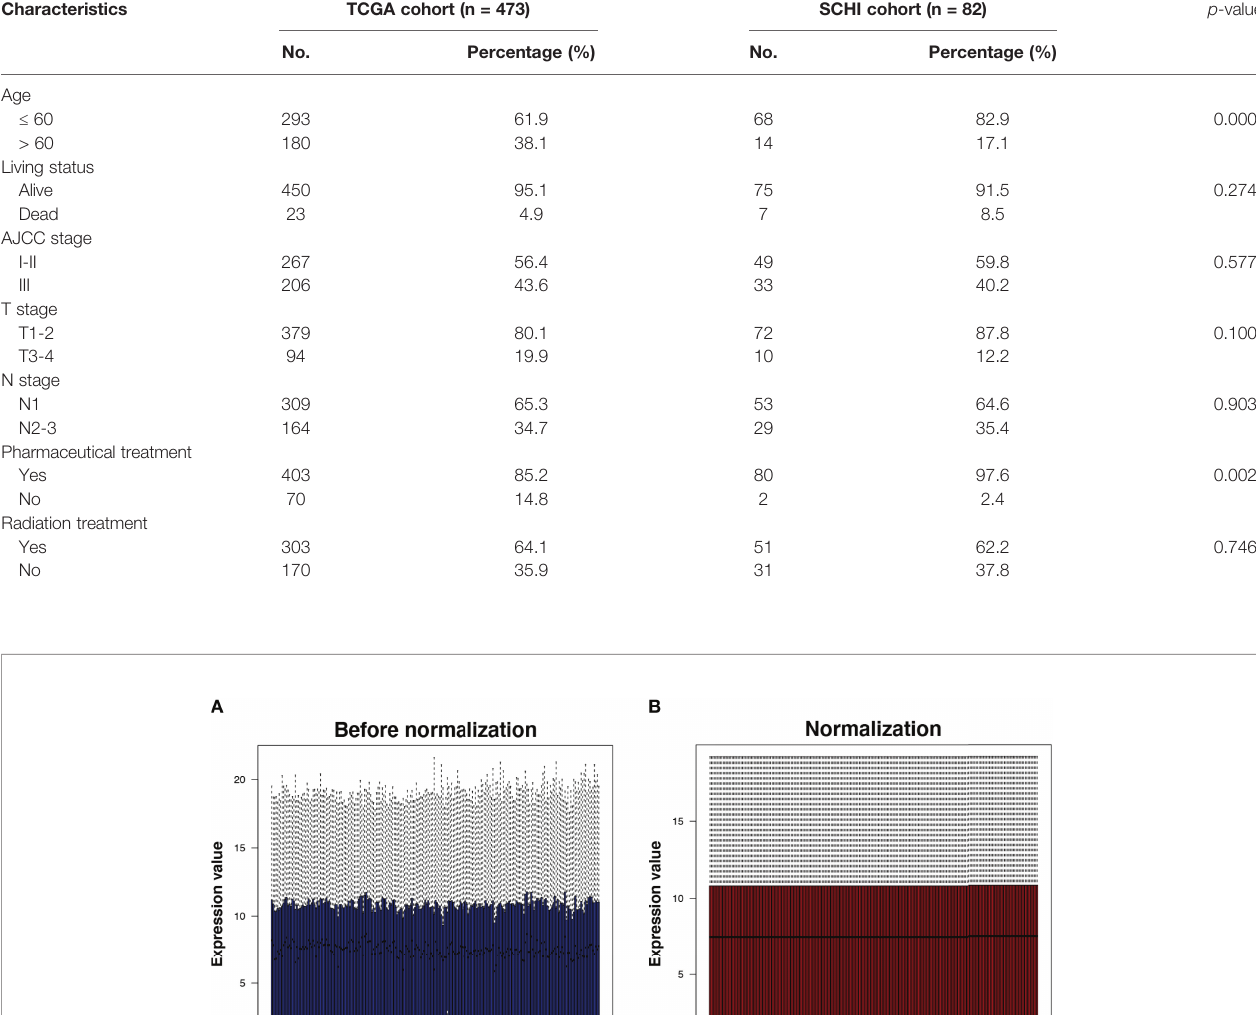
TABLE 1 | Clinical features of the TCGA and SCHI